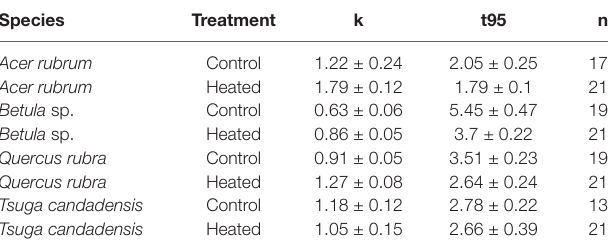
TABLE 4 | Decay constants and t95 values for litterbag mass. For each set of litterbags (species × treatment), mean decay constant (k), time in years to decompose to 5% of initial mass (t95), and number of litterbags successfully retrieved and analyzed (n). Errors reported are standard error of the